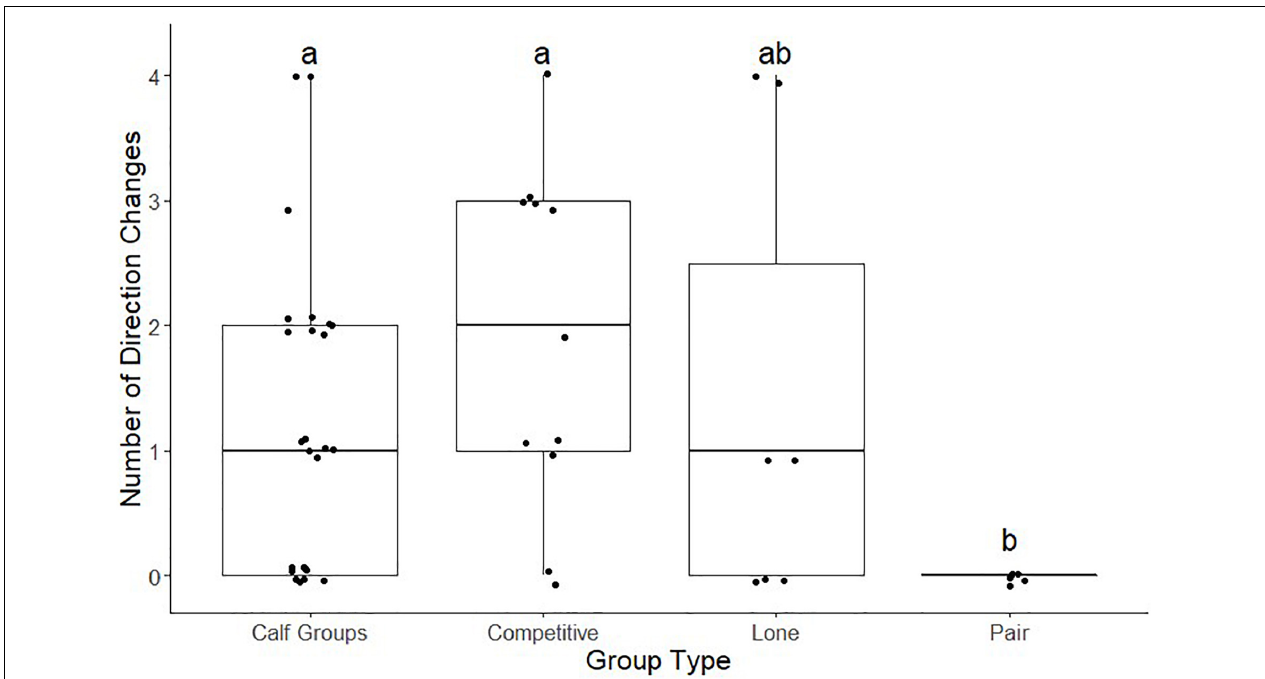
FIGURE 4 | Megaptera novaeangliae. Box plot comparing the number of direction changes of four different whale group types (competitive groups, lone groups, calf groups, and pairs). Groups with shared letters are not significantly different.